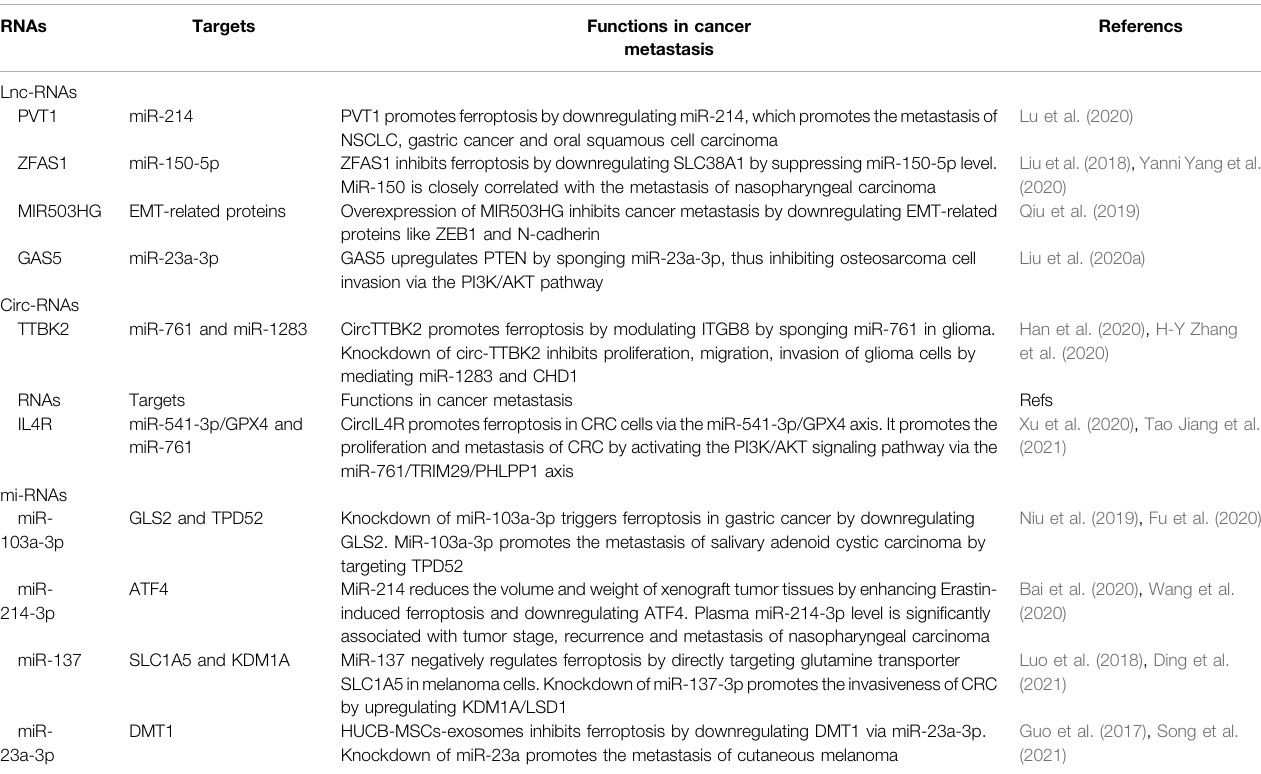
TABLE 3 | Noncoding RNAs regulate ferroptosis in cancer metastasis.